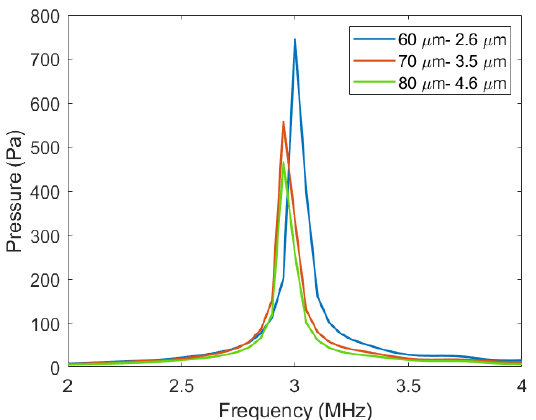
Figure 7. The sound pressure of different membrane radius thickness combinations.